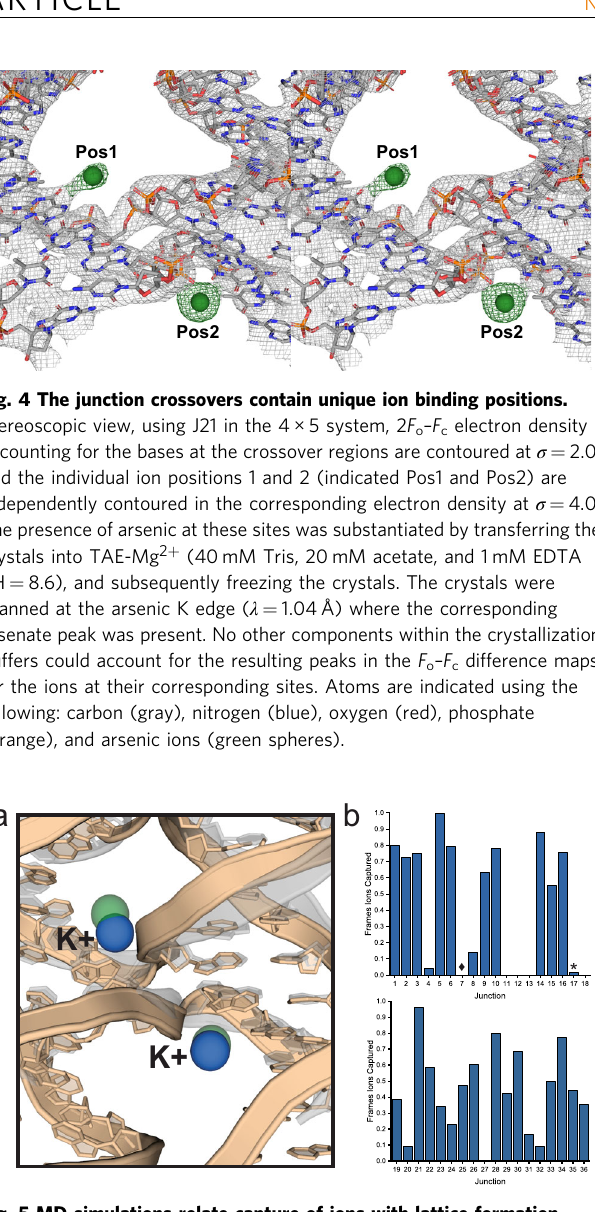
NATURE COMMUNICATIONS| (2022) 13:3112